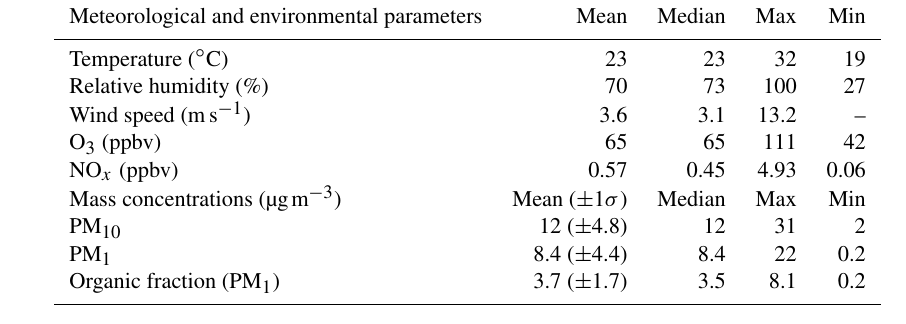
Table 1. Meteorological conditions, environmental parameters and mass concentrations of PM 10 , PM 1 and organic fraction in PM 1 during the ChArMEx campaign at Ersa.